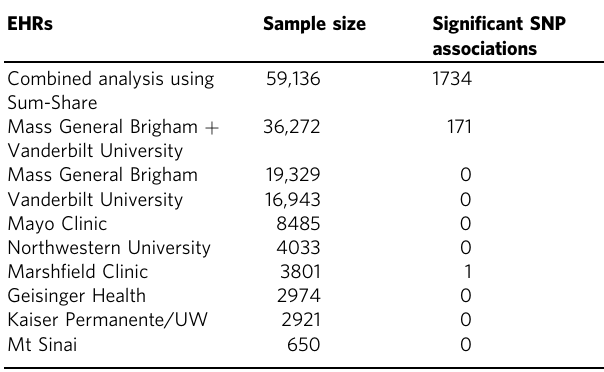
Table 1 Signi fi cant SNPs identi fi ed from individual and combined EHR